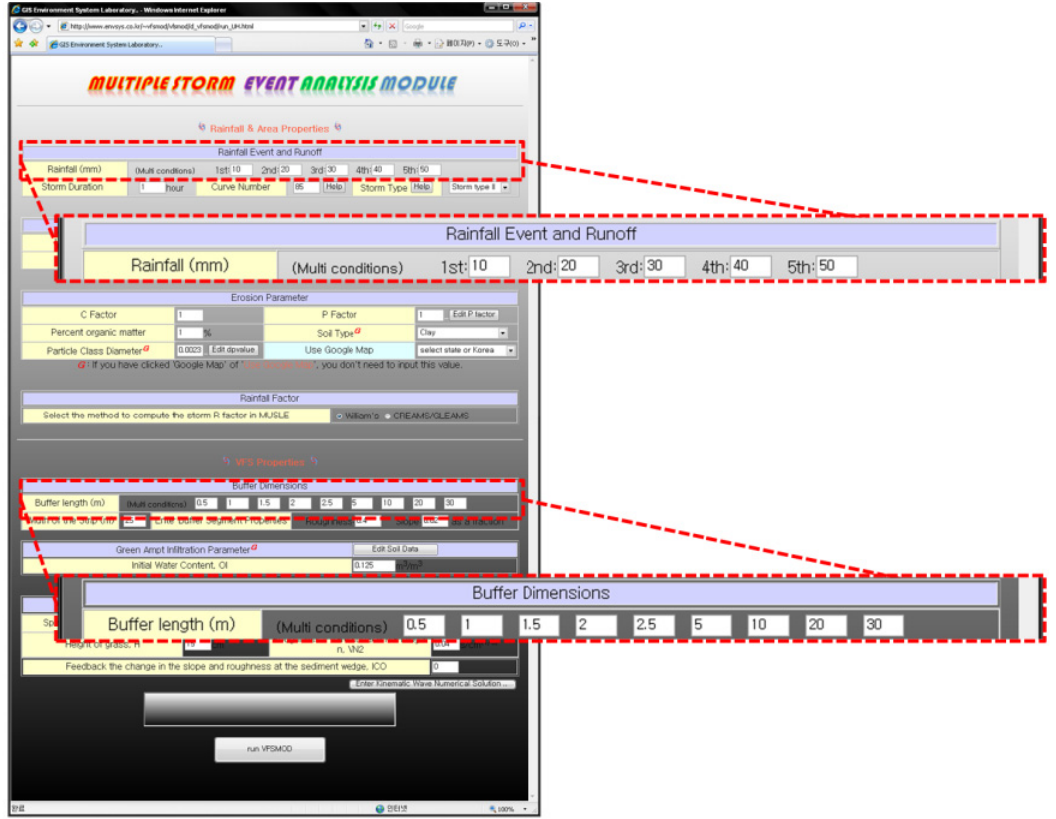
Figure 6. Multiple Storm Events Analysis (MSEA) module in the Web GIS-based VFSMOD